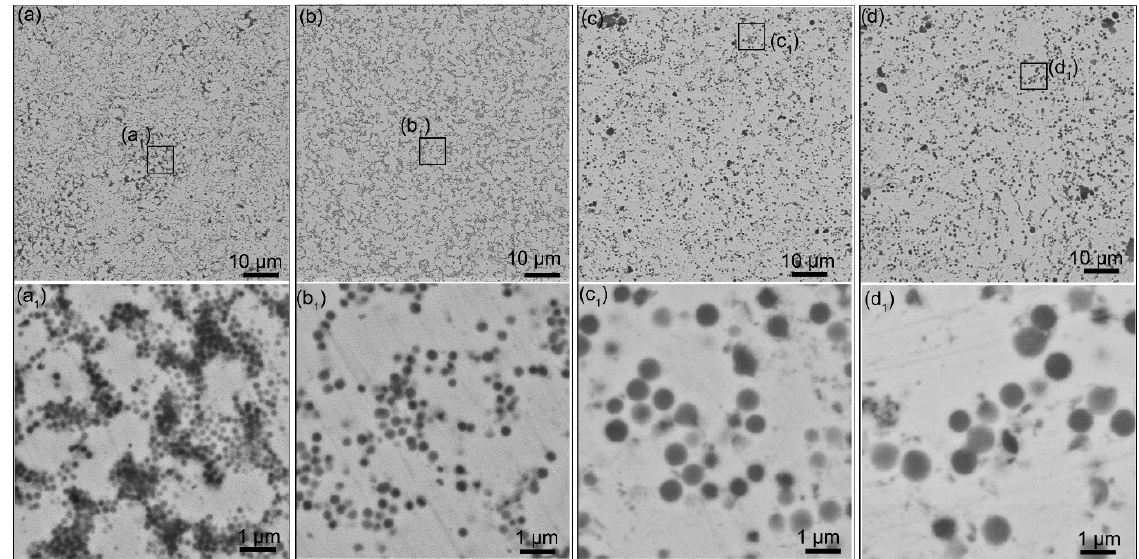
Figure 4. ( a – d ) Low- and ( a 1 – d 1 ) high-magnification SEM images of Ag/Y 2 O 3 sintered compacts. The mean size of Y 2 O 3 used: ( a , a 1 ) 243 nm, ( b , b 1 ) 387 nm, ( c , c 1 ) 792 nm, ( d , d 1 ) 980 nm.